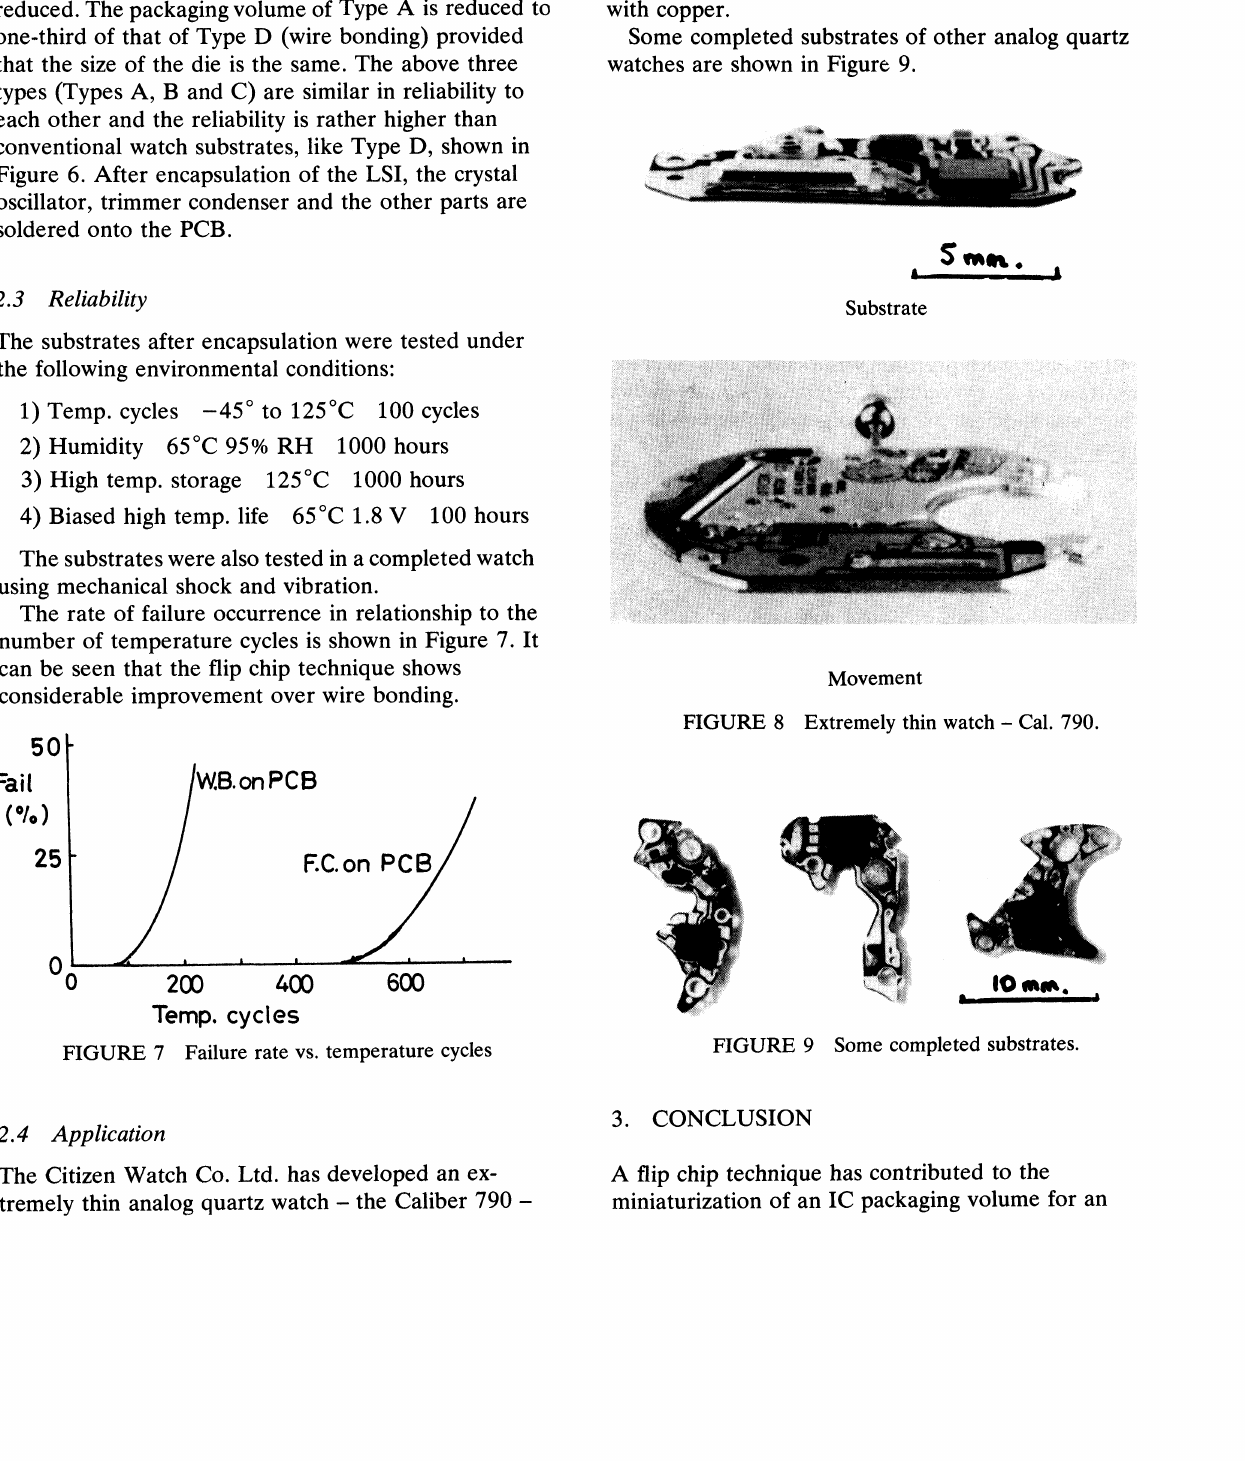
FIGURE 9 Some completed